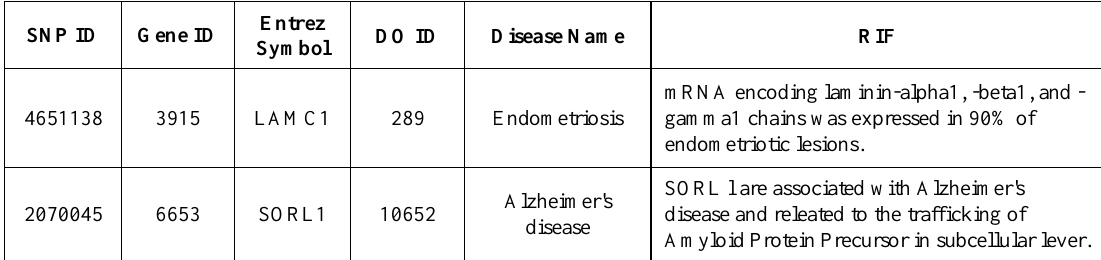
Table 3: Sample DO-GeneRIF information according to AHP based ranking for Alzheimer’s